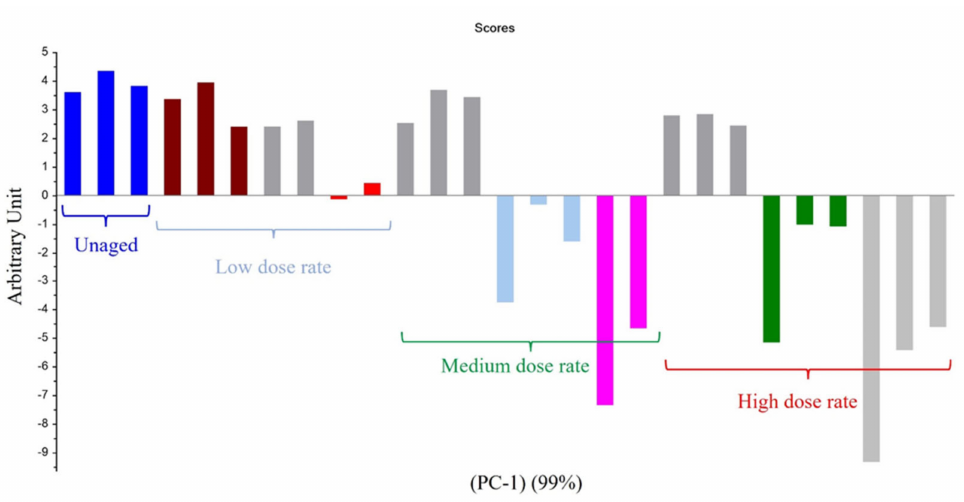
Figure 13. PC1 results on Mod7: first irradiation doses (kGy) with dose rates (Gy/h).